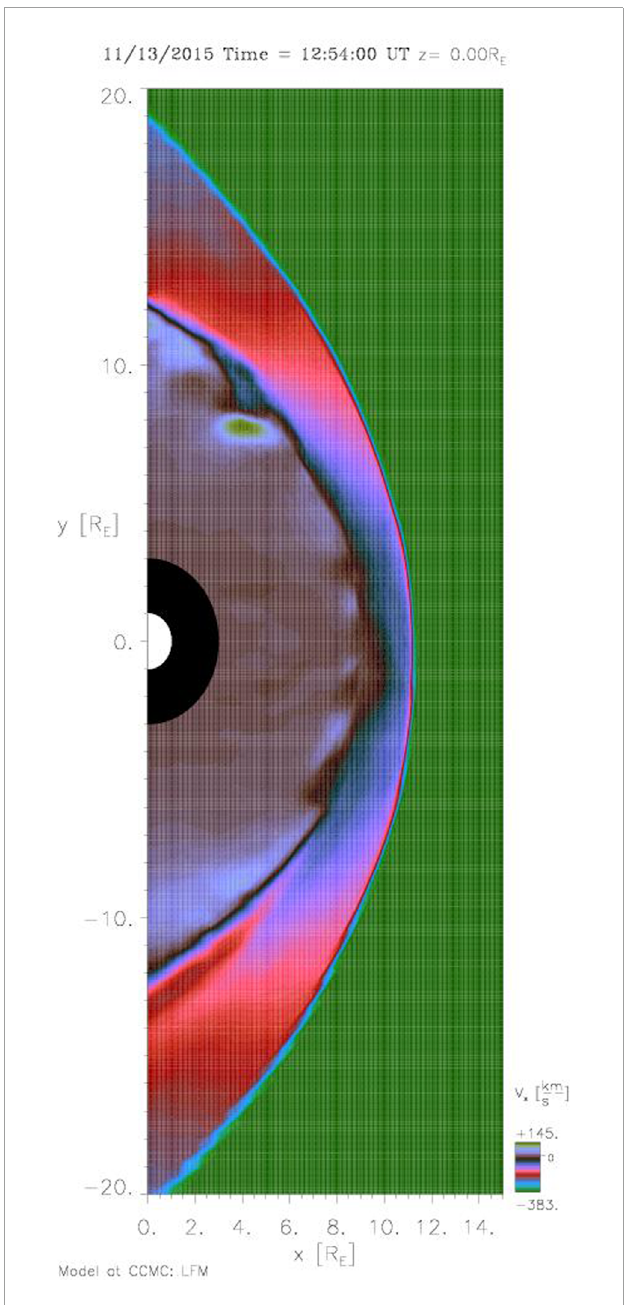
FIGURE 9 The equatorial plane in the LFM simulation at 12:54 UT, colored by the X component of the ion velocity. The bow shock was identified by eye using a plot like this for the integration of the J z on the bow shock described in Section 4 . (Plot generated by the